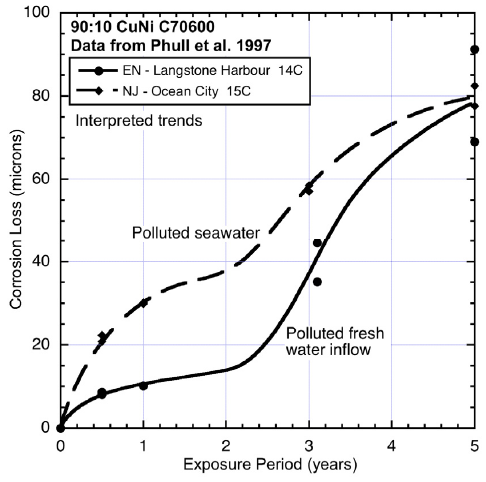
Figure 3. Data and interpreted trends for colder seawater sites DK, BM and ST.